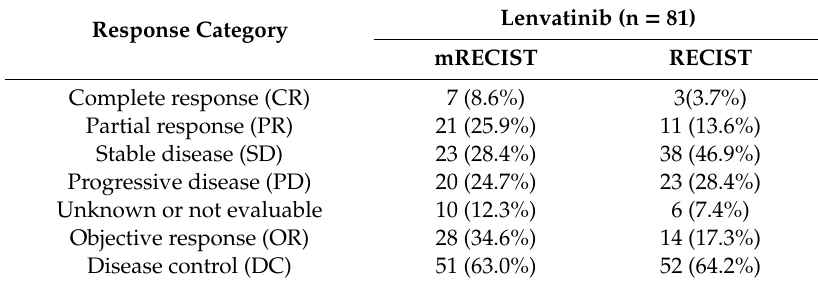
Table 3. Summary of e ffi cacy measures, according to modified Response Evaluation Criteria in Solid Tumors (mRECIST) and Response Evaluation Criteria in Solid Tumors